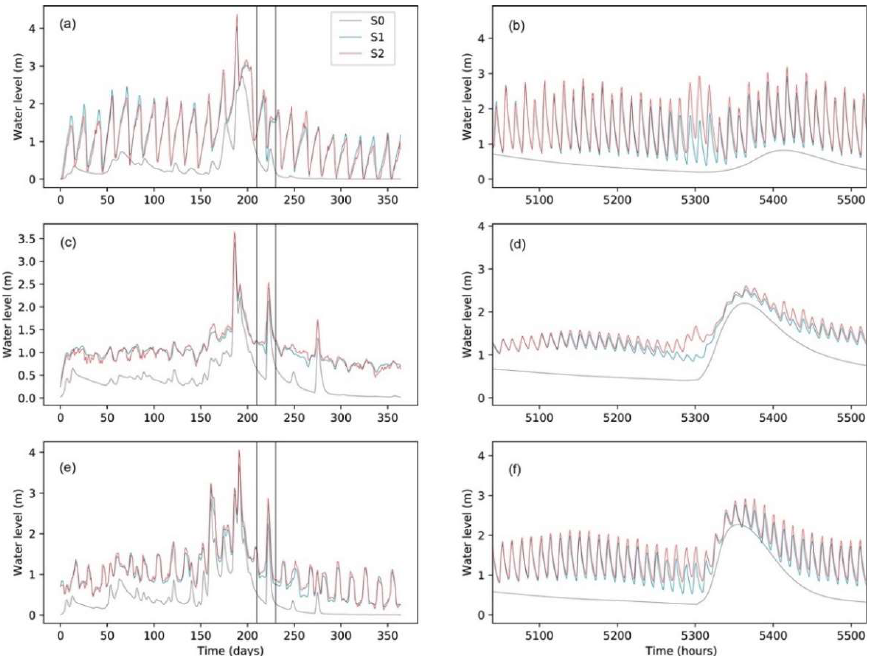
Figure 6. Variations in the river water level at the three coastal unit catchments. ( a , b ), ( c , d ), and ( e , f ) represent the series in p0, p1, and p2 from top to bottom, respectively. ( a , c , e ) show the different scenarios for the daily scale, and ( b , d , f ) show the variations on the hourly scale. Figure 7a,b illustrate the impact of tides on the river water level more clearly. In gen- eral, the fluctuation in the water level was highly correlated with that of the sea level, showing that the rivers are affected by the downstream water levels. A superposed tide ocean water levels at the daily scale (Figure 4) but weakened the fluctuation in river water level at the hourly scale as a buffering effect. Figure 7c illustrates that a stronger surge effect was captured in the river channel at p0 when the peak increase in the water level reached 1.5 m compared to 1.0 m in the ocean grid. At the hourly scale, the peak increase in water level was 1.5 m in the unit catchment but lower than 3.0 m at the downstream ocean grid (Figure 5b). However, the high water levels lasted longer than those of the downstream ocean grid (Figure 7d). These simulation results indicate that the longer pe- riodic signal (i.e., the spring–neap cycle) is more easily transported in the river than the short periodic signal (i.e., tidal cycle). The surge signal tends to change from high fre- quency to low frequency as it propagates from ocean to river, thus leading to longer-last- ing effects of waterlogging in the cities.